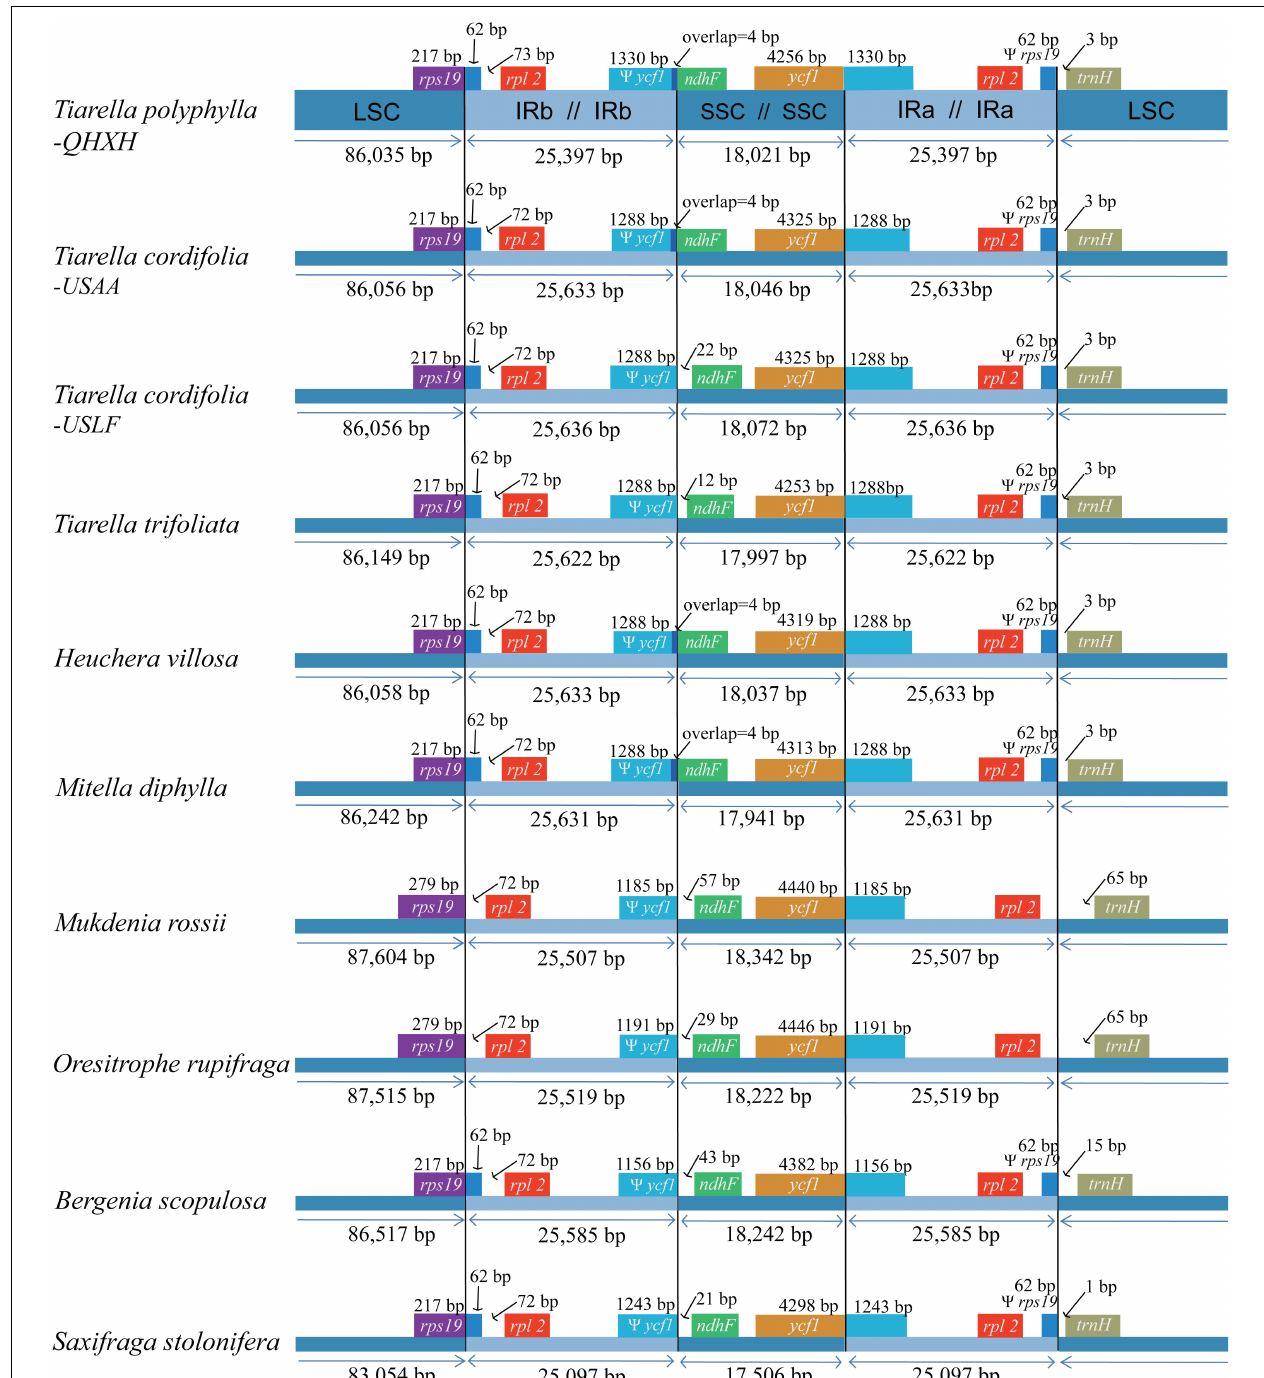
FIGURE 3 | Comparison of boundaries of the large single-copy (LSC), small single-copy (SSC), and inverted repeat (IR) regions among the ten Saxifragaceae plastomes. We show only Heuchera villosa and Mitella diphylla as representative of identical boundary types in these genera. For the location of the two inverted repeat regions (IR A and IR B ), refer to Figure 1 .